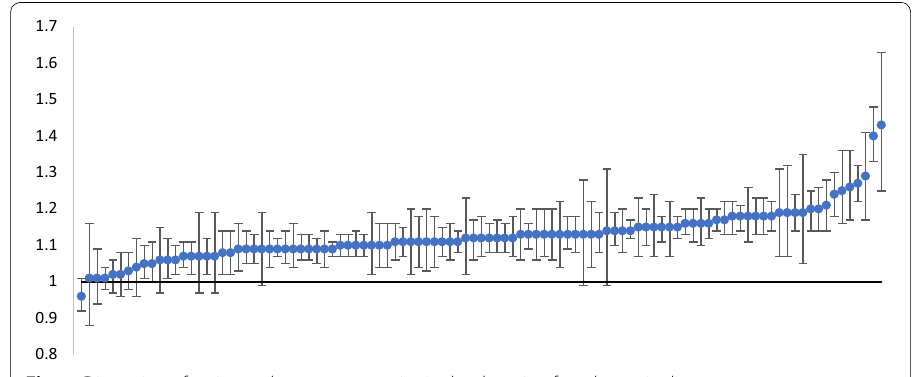
Fig. 1 Dispersion of variances between countries in the domain of mathematics